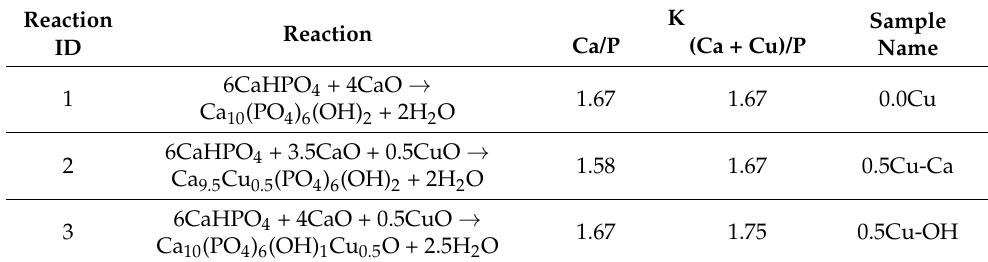
Figure 2. Schematic representation of the experiments. Table 1. Expected reactions of mechanochemical synthesis.